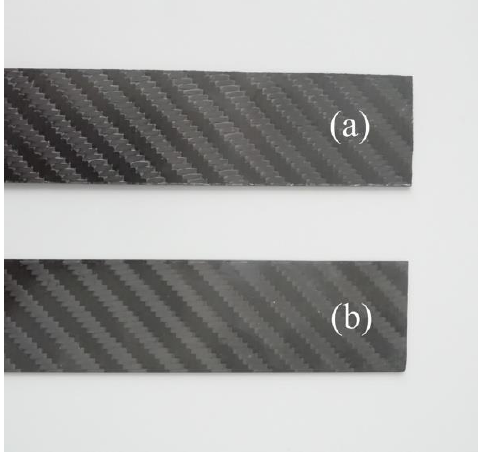
Figure 4. Manufacturing process of CFRE specimens: ( a ) cutting of 30 × 200 mm specimens; ( b ) finished specimens; and ( c ) detailed visual comparison of the surface of autoclave and VBO top surfaces.